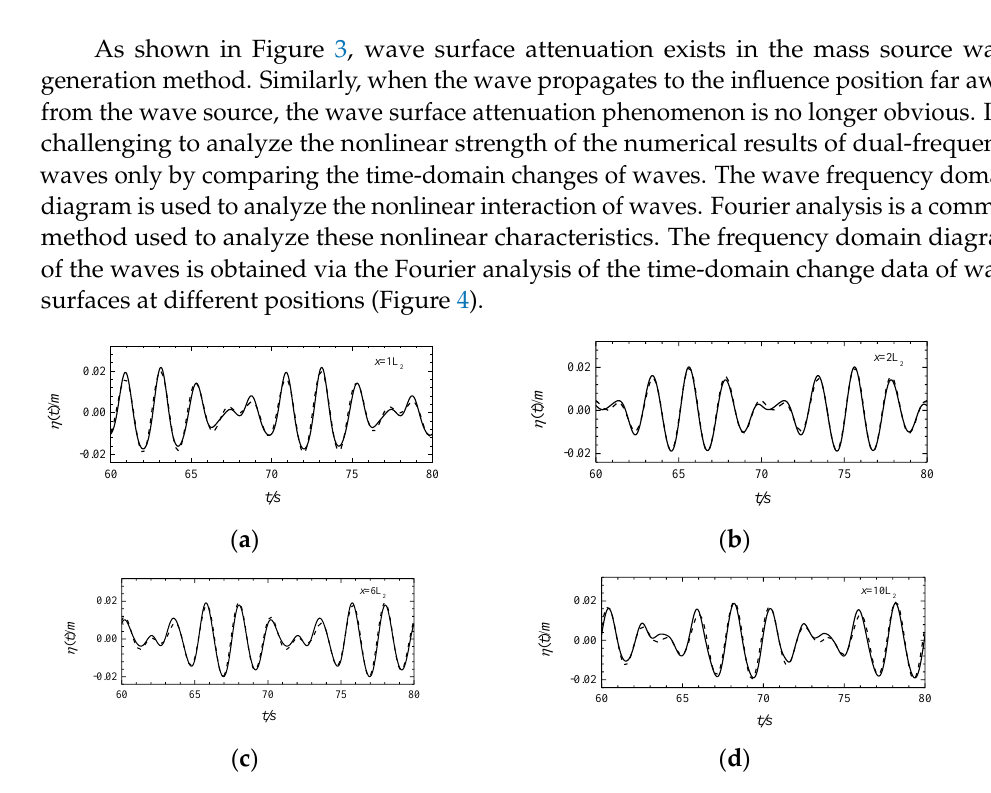
Table 3. Main frequencies of the C2 spectrum analysis under working conditions.